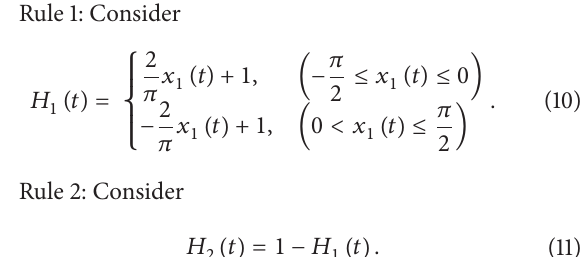
Figure 2 is the membership function for the fan of nonlinear